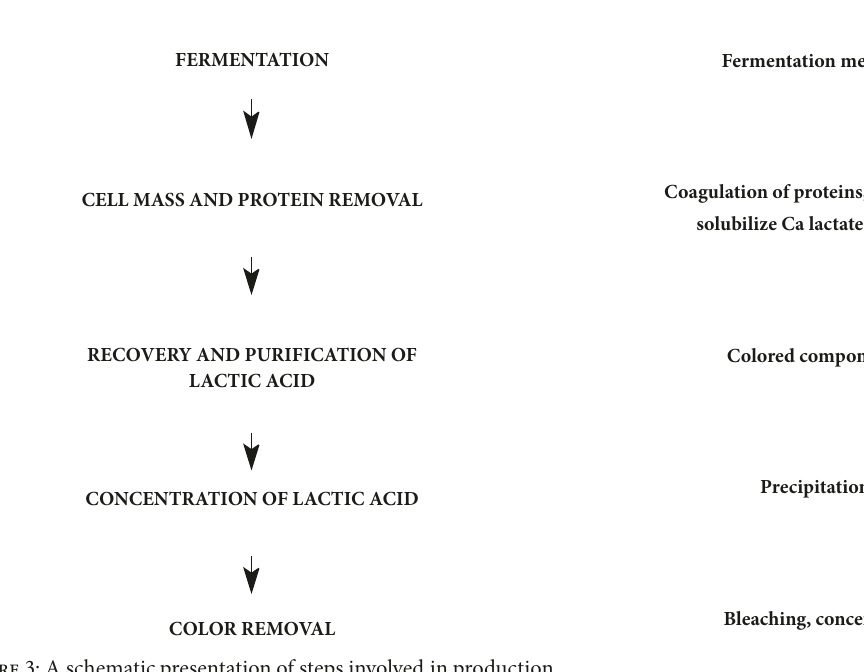
Figure 3: A schematic presentation of steps involved in production and purification of lactic acid by fermentation.